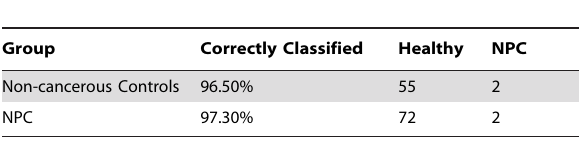
Table 3. Validation of the serum 4-miRNA based diagnosis model in 131 cases of serum